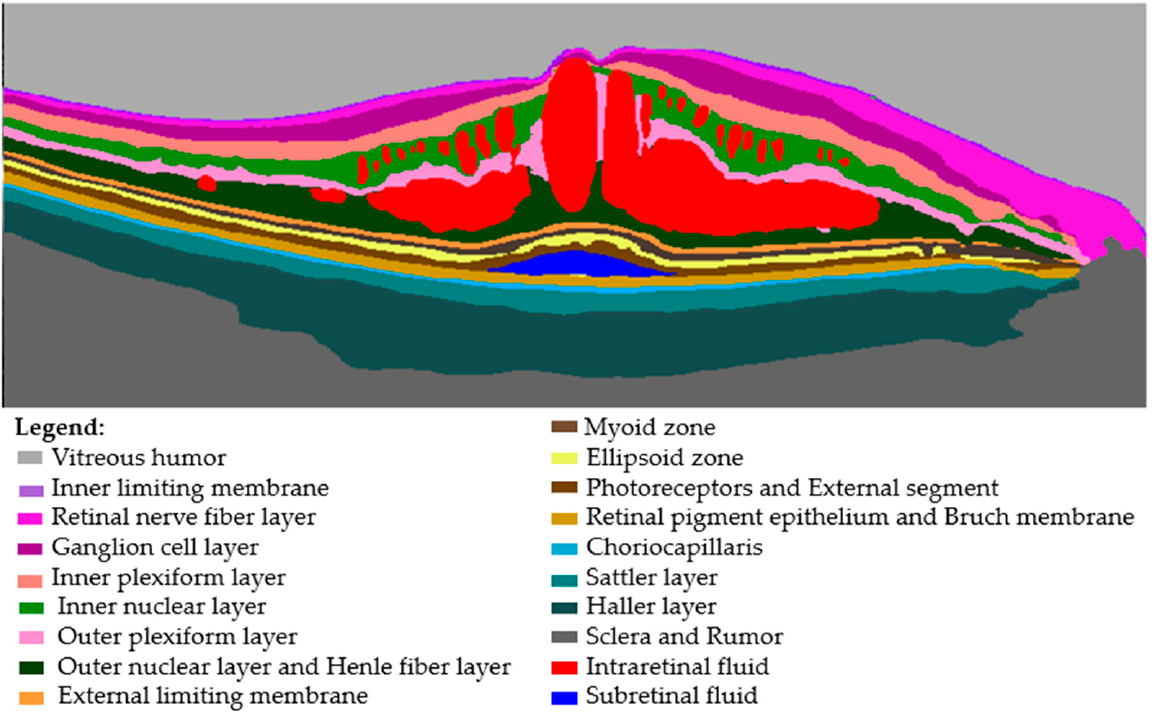
Figure 2. Retinal layer segmentation.